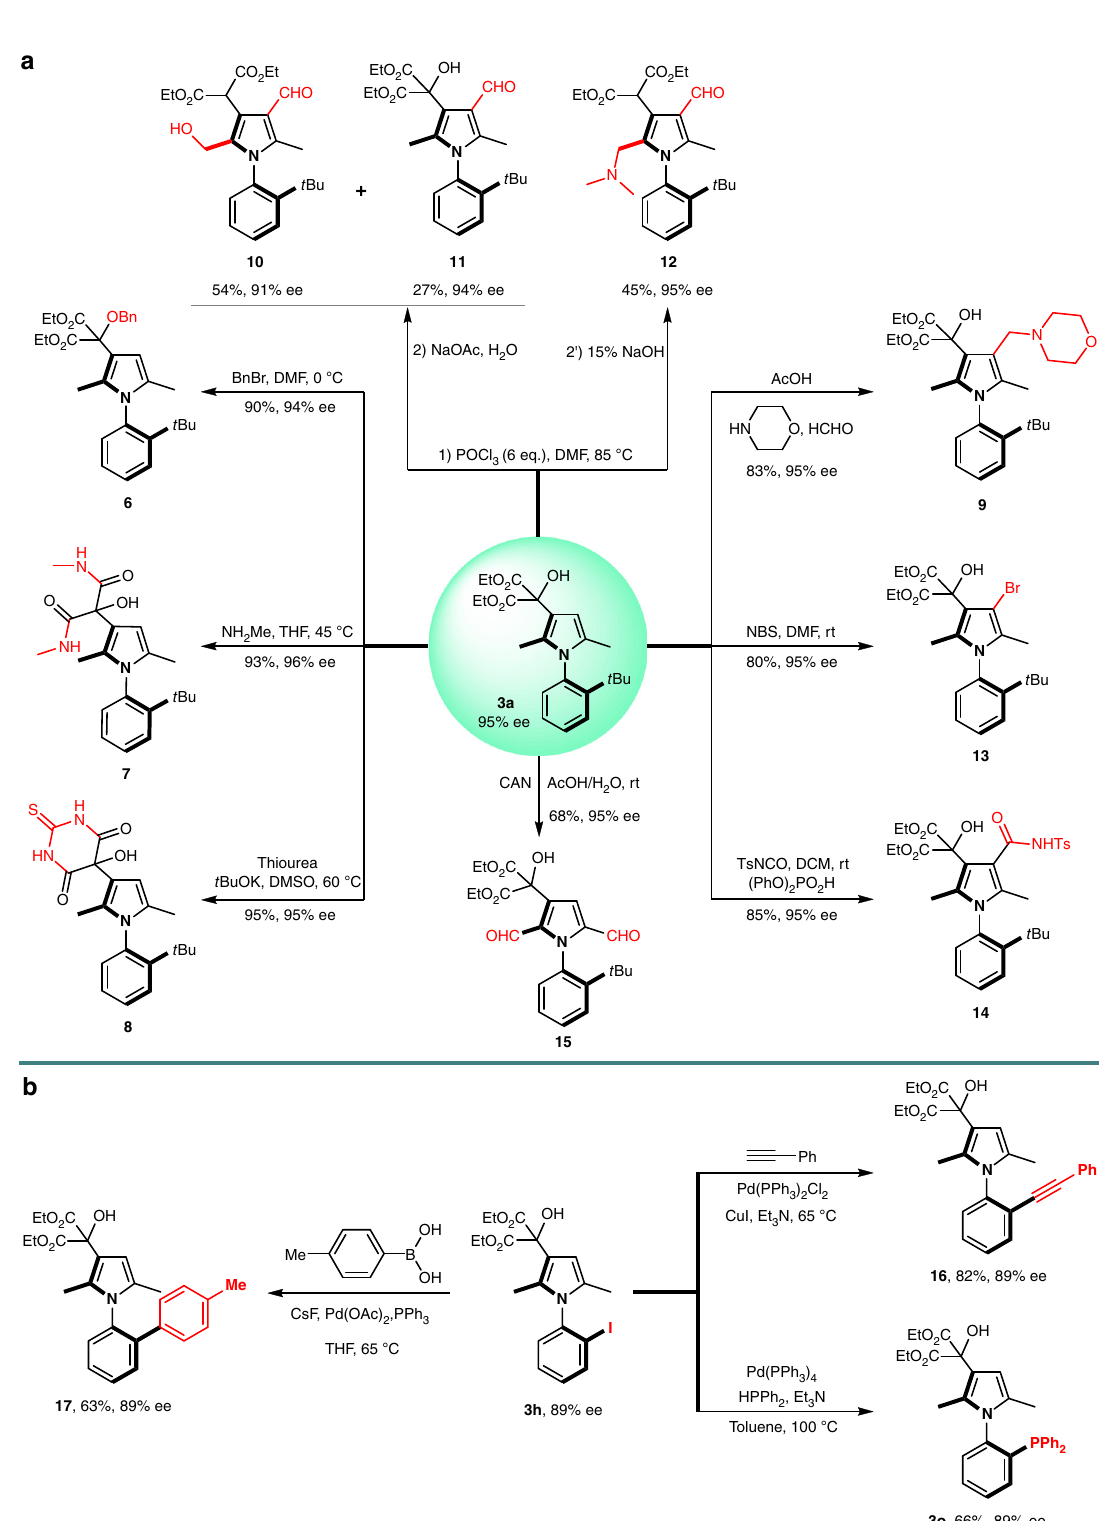
Fig. 3 Versatile synthetic transformations. a Synthetic transformations of compound 3a . Ts, p -toluenesulfonyl. b Synthetic transformations of compound General procedure for the synthesis of ( R )-3 . An oven-dried 10 mL of Schlenk tube was charged with arylpyrroles 1 (0.30 mmol), ( S )- C8 (0.01mmol), 2.0mL of dry cyclohexane, and the mixture was stirred at ambient temperature for 10min. A solution of ketomalonate 2a (0.20 mmol) in dry cyclohexane (1.0 mL) was added dropwise to the above solution and the mixture was stirred until the starting material was completely consumed. Then the mixture was concentrated under